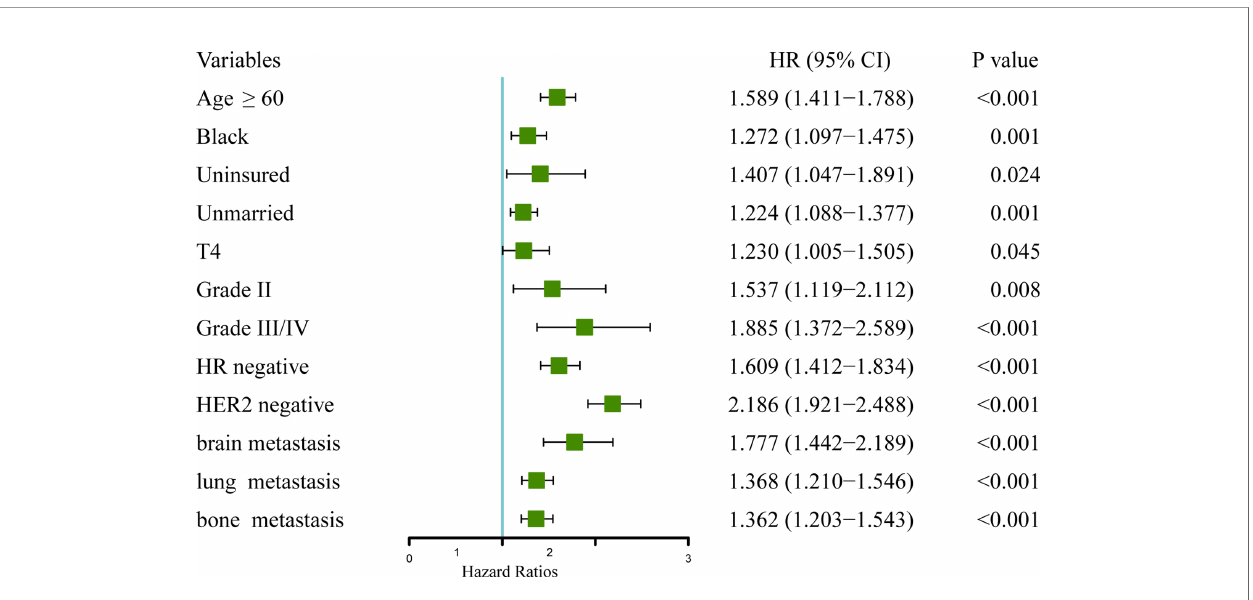
FIGURE 2 | Forest plot showing the results in the multivariate Cox regression